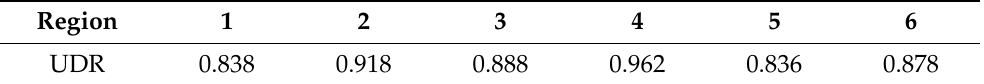
Table 2. Uniqueness Degree of a Functional Region (UDR) Assessment of the LRA method.